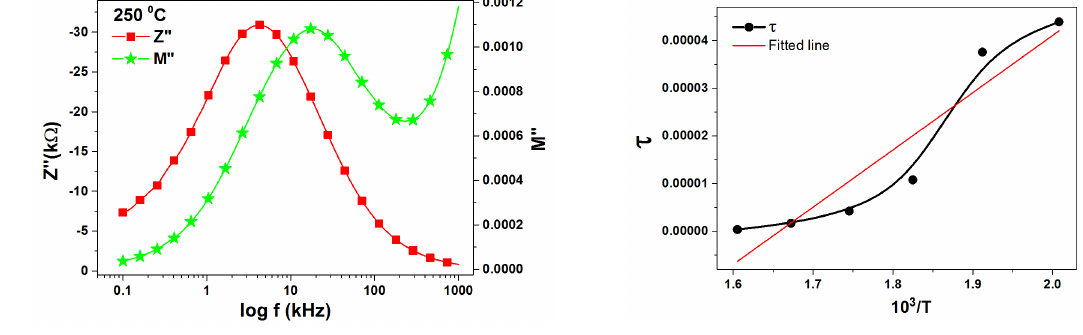
Fig. 10 Variation of Zʹʹ and Mʹʹ with frequency at (250 0 C) temperature of